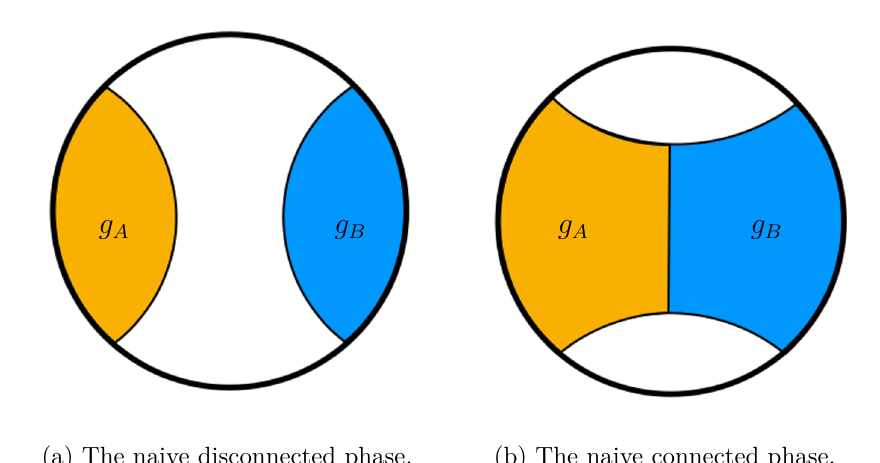
Figure 6 . Two naive solutions for the bulk spin model. The white region indicates the identity permutation e